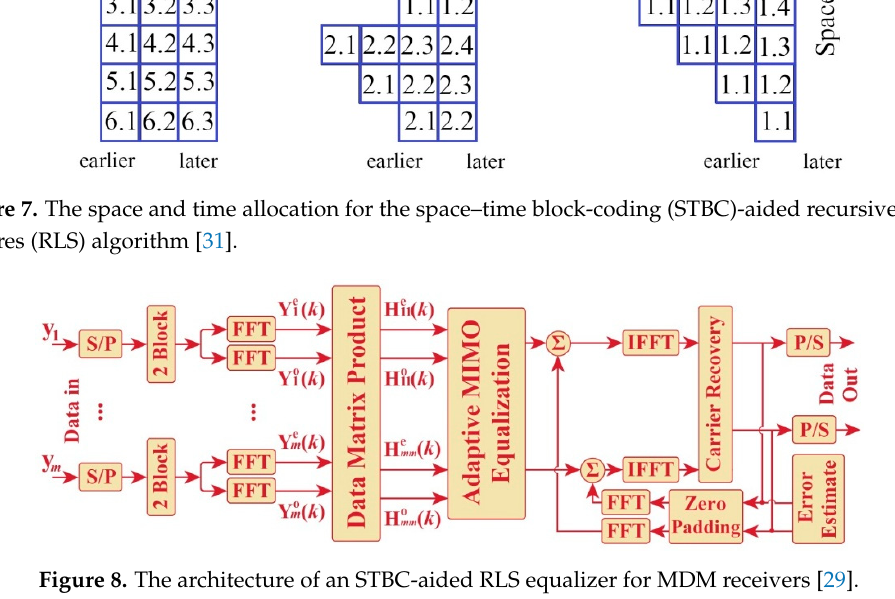
Figure 8. The architecture of an STBC-aided RLS equalizer for MDM receivers [29].